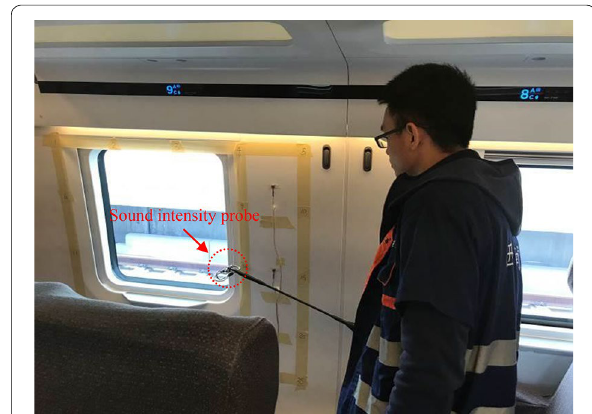
Figure 22 Photograph of the interior sound intensity measurement